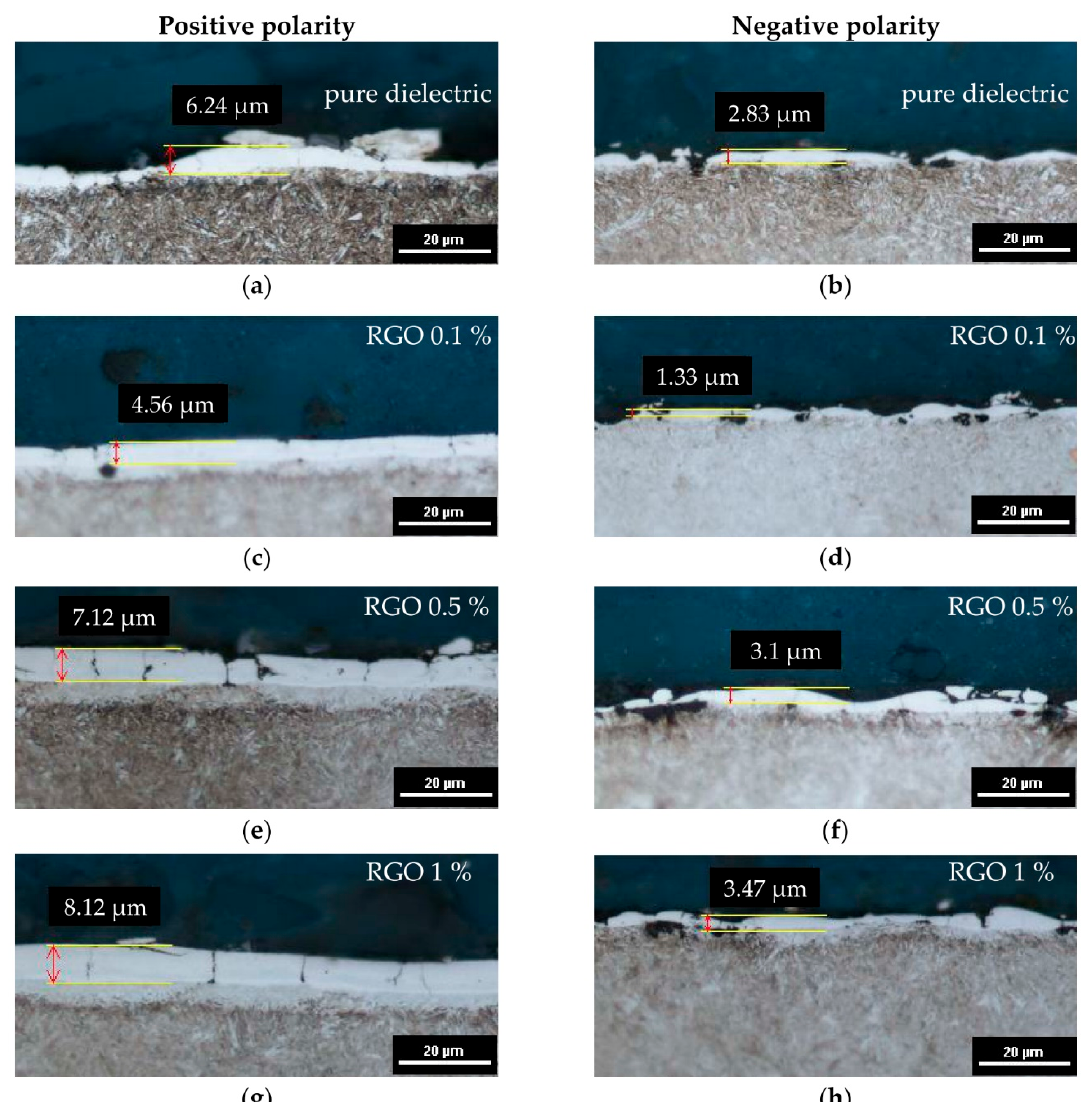
Figure 9. Metallographic structure of tool steel 55NiCrMoV7 after PMEDM: ( a , b ) Uc = 25 V, I = 1 A, t on = 5 µ s, t off = 5 µ s, dielectric without RGO; ( c , d ) Uc = 25 V, I = 1 A, t on = 5 µ s, t off = 5 µ s; RGO = 0.1%; ( e , f ) Uc = 25 V, I = 2 A, t on = 8 µ s, t off = 5 µ s, RGO = 0.5%; ( g , h ) Uc = 25 V, I = 2 A, t on = 8 µ s, t off = 5 µ s, RGO = 1%.